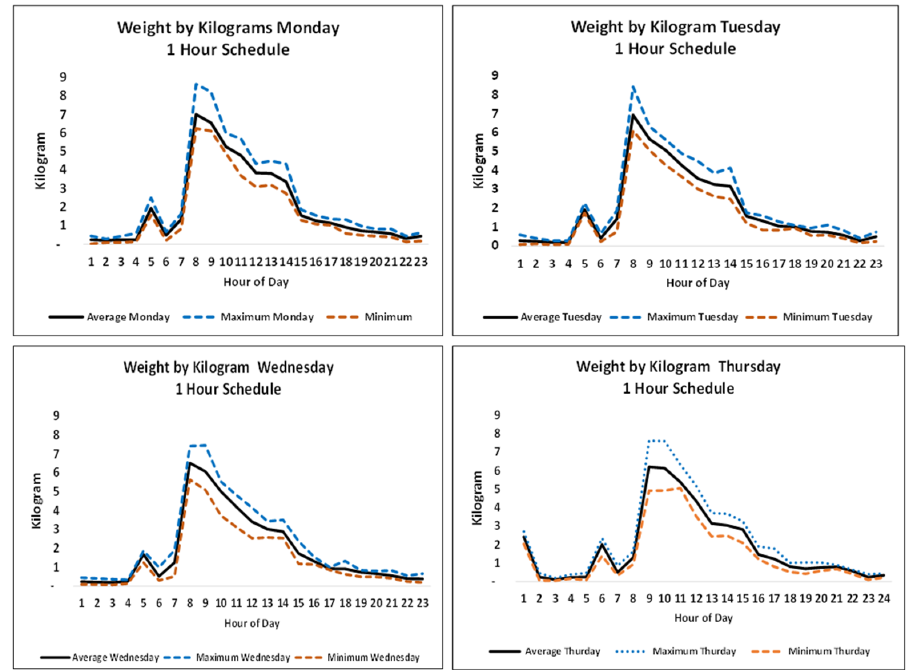
Figure 6. Average, maximum and minimum hourly payload weights on Monday–Thursday for 8 weeks of routine analyses at the medical biochemistry laboratory. Each maximum value was taken from the day with the highest value.